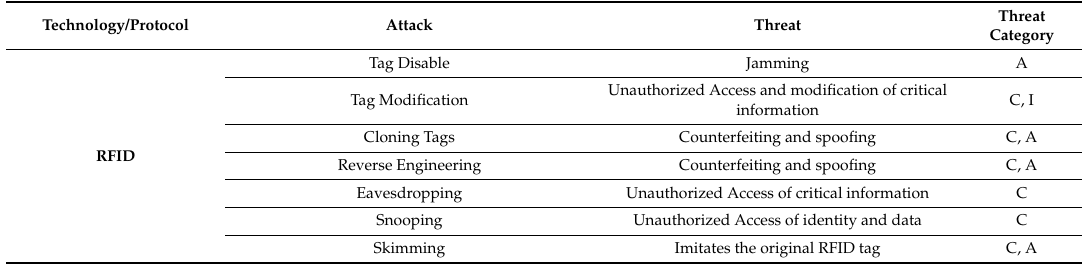
Table 3. Summary of attacks against main IoT technologies (C: Confidentiality, I: Integrity, A: